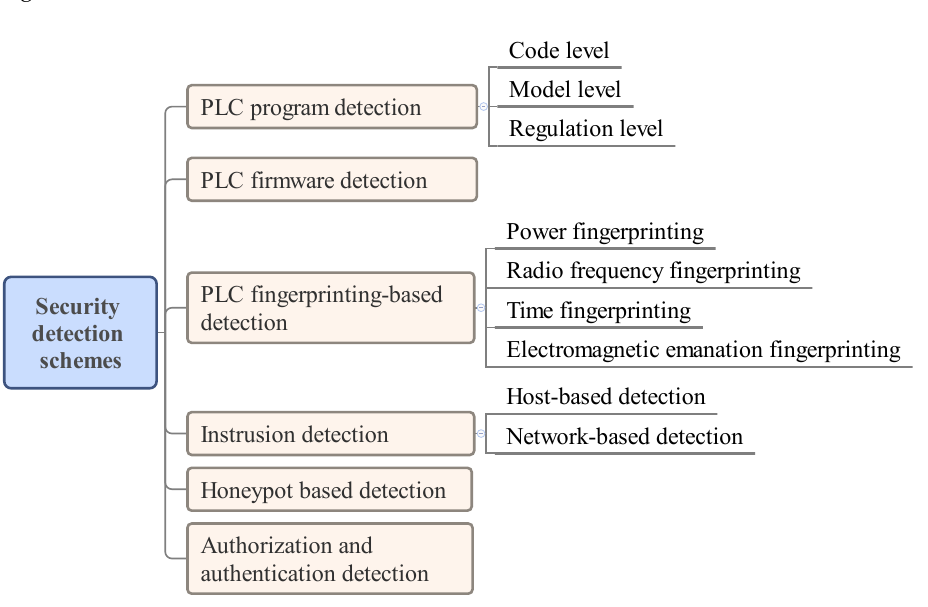
Figure 5. Classification of security detection schemes in PLC-based control